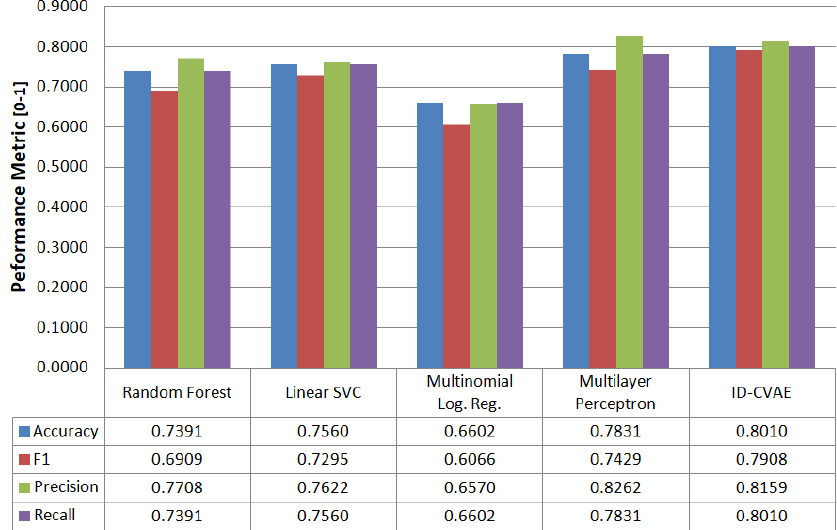
Figure 5. Classification performance metrics (aggregated) vs. different classifiers.